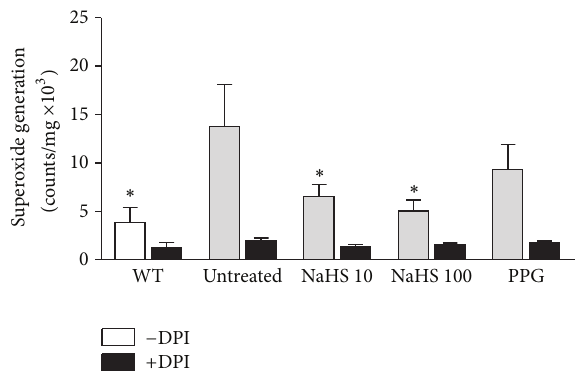
Figure 4: Superoxide generation in aorta from WT control (open bar) and fat-fed ApoE −/− mice (shaded bar) treated with either NaHS (10 or 100 𝜇 mol/kg/day) or PPG (30mg/kg/day). Vascular superoxidegenerationwassignificantlyincreasedinfat-fedApoE −/− mice ( # 𝑃 < 0.05 , 𝑡 -test, WT versus ApoE −/− , 𝑛 = 7 ). Vascular superoxide production was significantly impaired in the groups treated with either 10 or 100 𝜇 mol/kg/day NaHS. ( ∗ 𝑃 < 0.05 , ANOVA, versus untreated group, 𝑛 = 7 ). PPG treatment had no effect. The flavoprotein inhibitor DPI, used to inhibit NADPH oxidase, virtually abolished the vascular superoxide signal (black